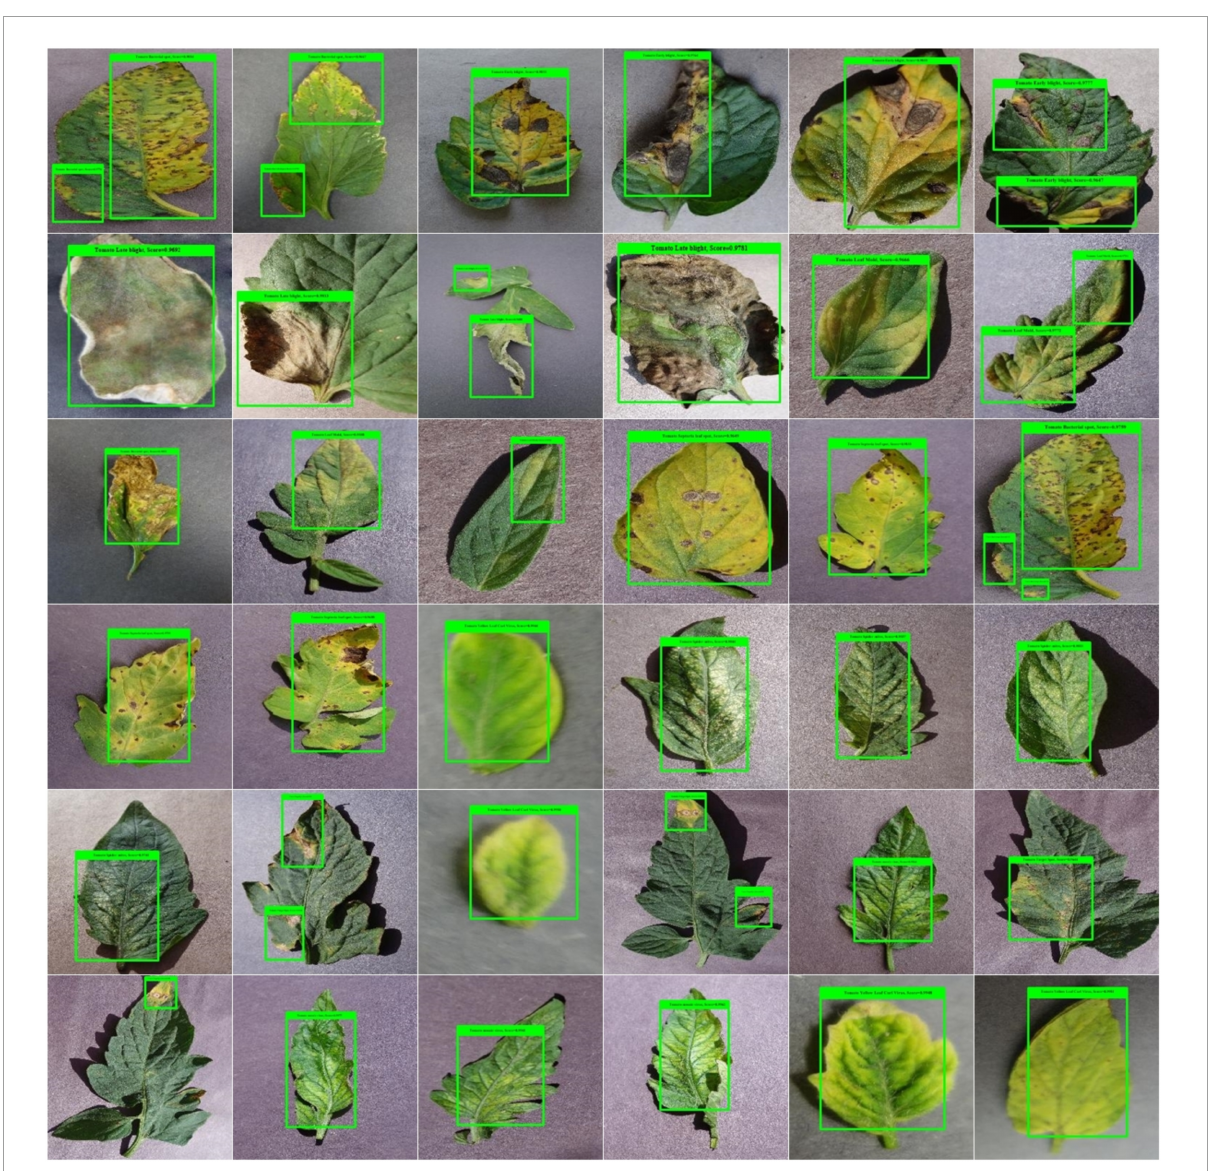
FIGURE7 A pictorial depiction of the localized tomato plant leaf diseases